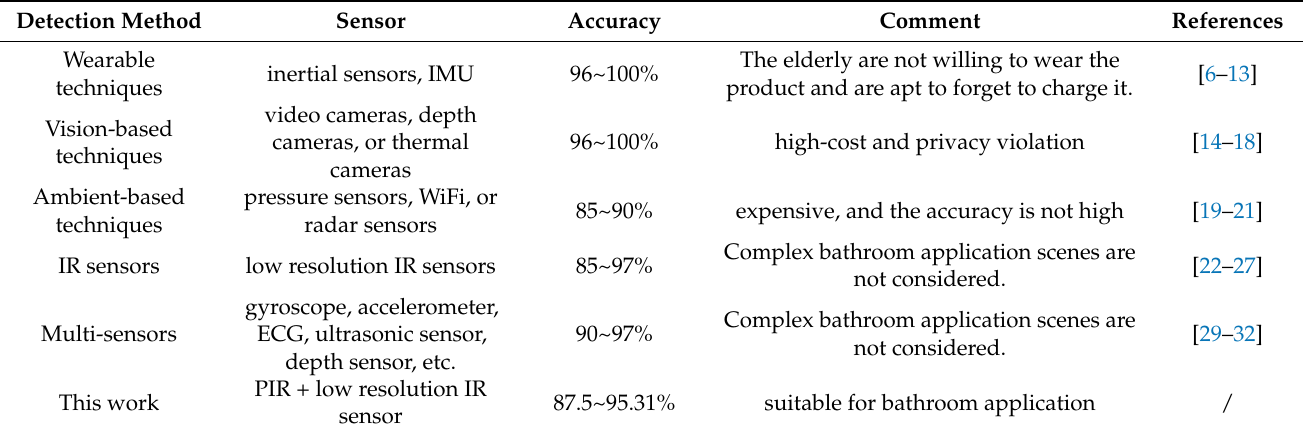
Table 3. Comparison of different fall detection